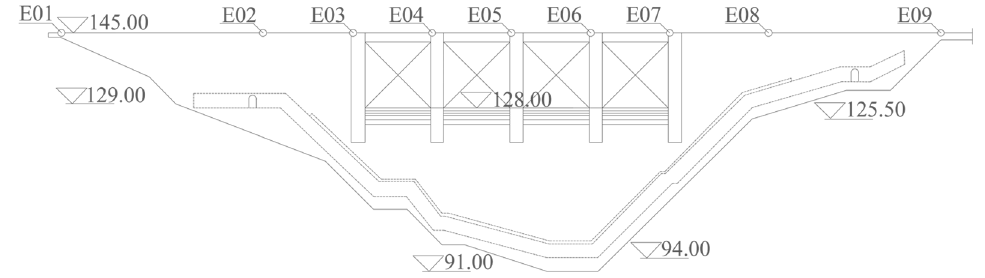
Figure 6. The layout of horizontal displacement measuring points on the dam.